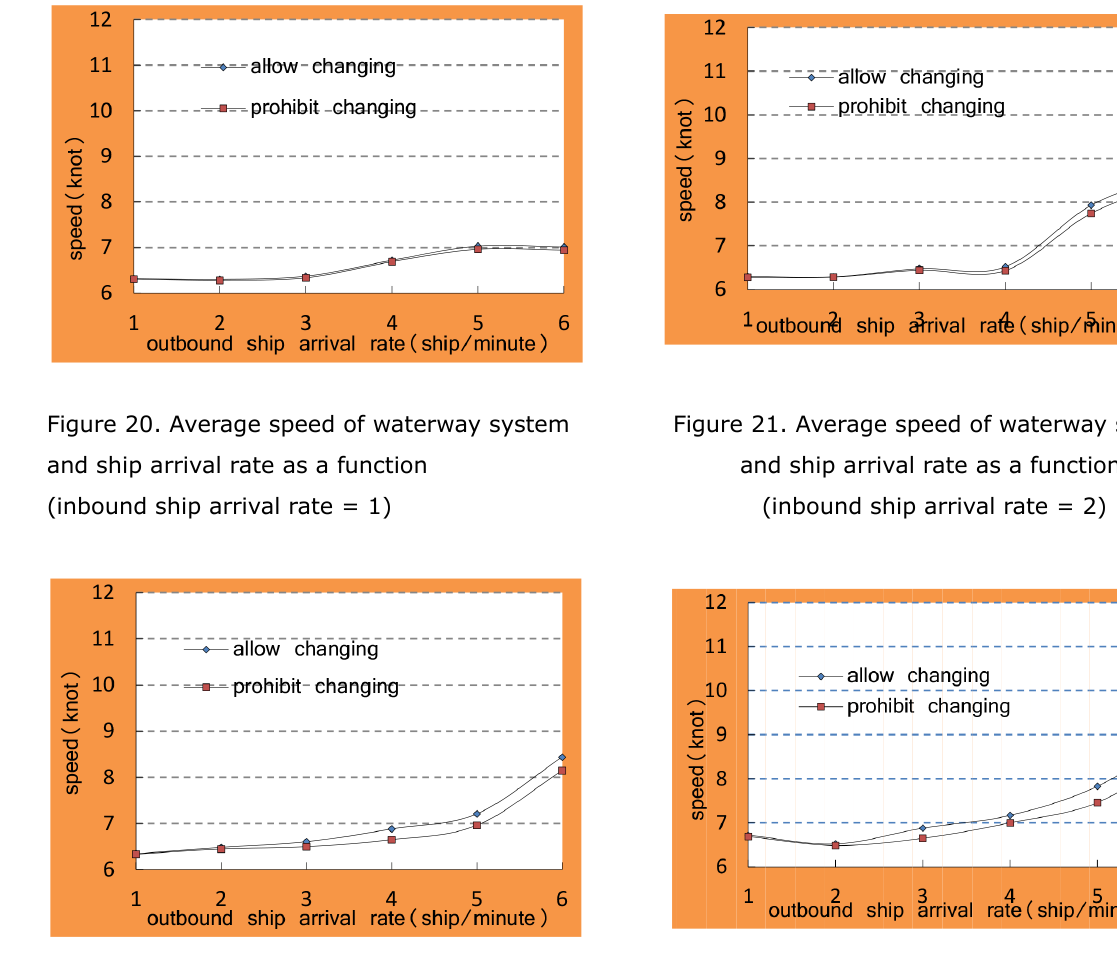
Figure 22. Average speed of waterway system and ship arrival rate as a function (inbound ship arrival rate = 3)